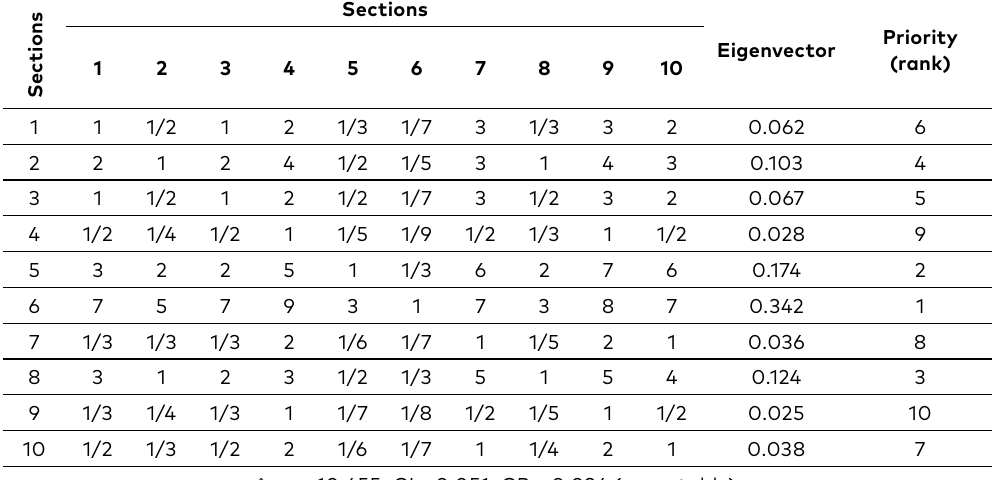
Table 7. Pairwise comparison of the accident